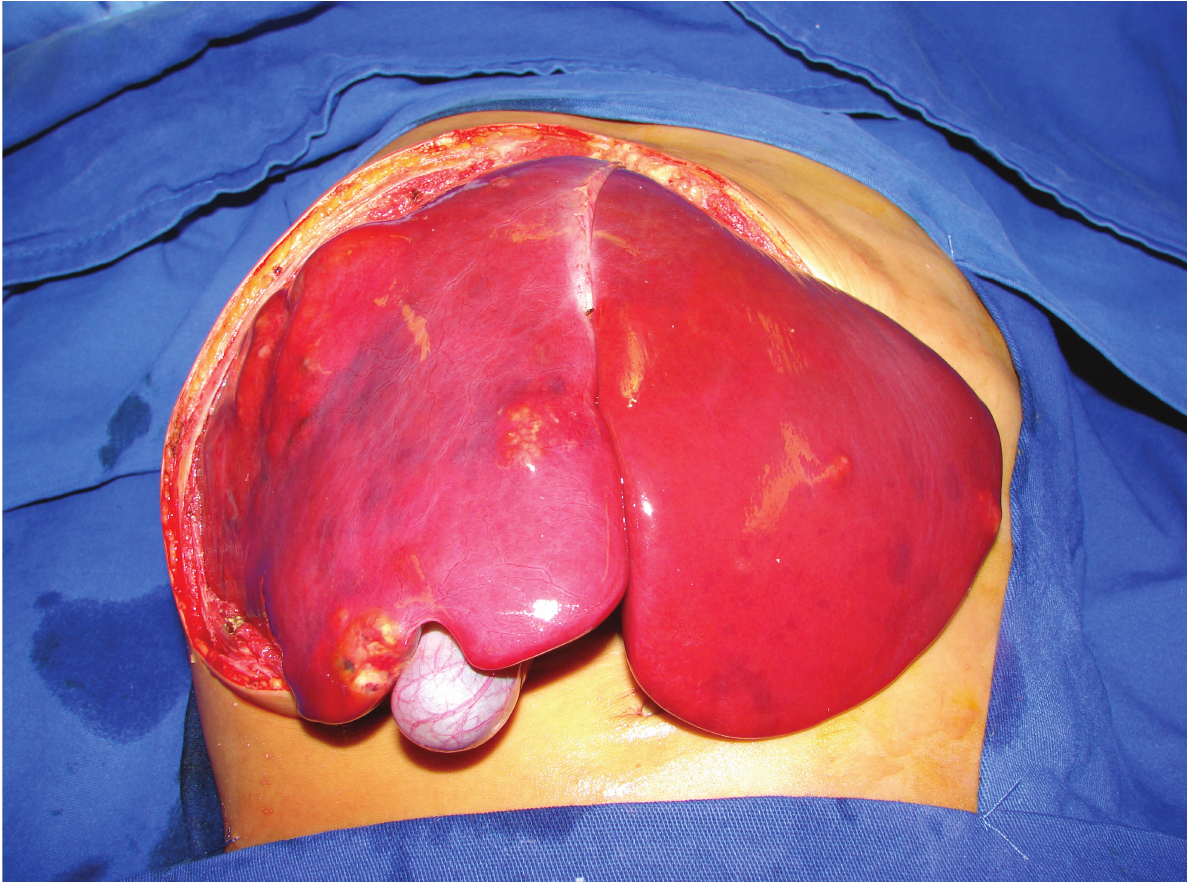
Figure 1 - Surgical aspect of a patient with multifocal hepatoblastoma. Note the multiple nodes affecting all of the liver parenchyma (PRETEX IV). The patient underwent total hepatectomy and living donor liver